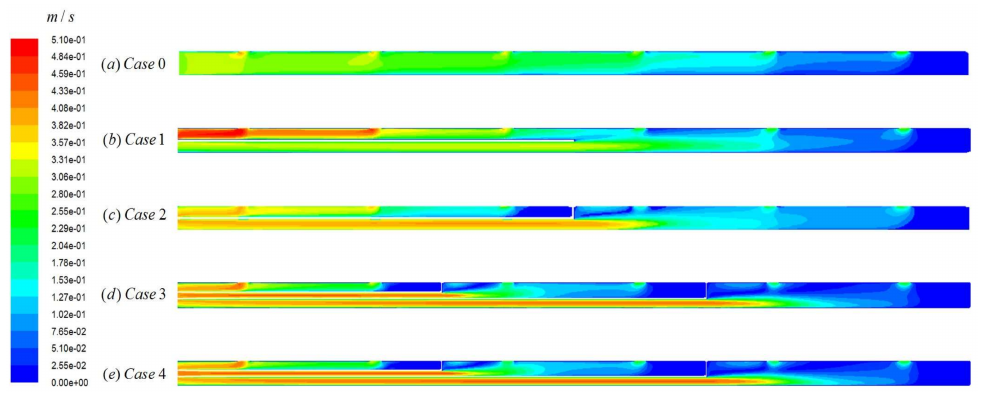
Figure 14. Velocity contours in the distribution manifold for the study cases. Table 7. Comparison of overall pressure drop for the study cases with 15 ◦ tilt angle (units in kPa).